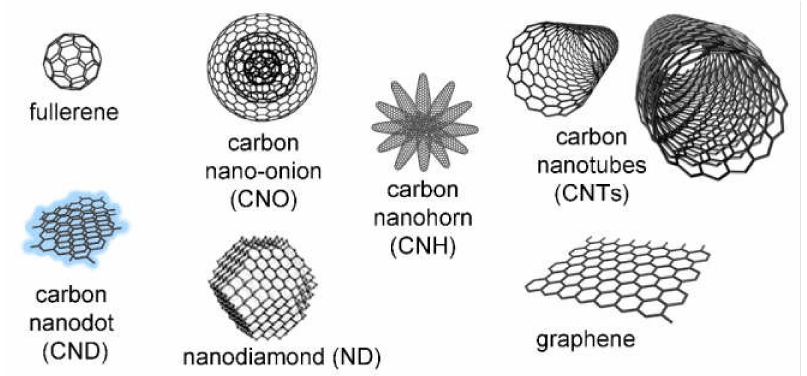
Figure 1. Carbon nanostructures (not to scale), reproduced from Adorinni, S. et. al. (2021) [41] under a Creative Commons license (https://creativecommons.org/licenses/by/4.0/). The nano-onion schematic structure is reproduced with permission from Ugarte, D. et al. (1996) [42], copyright ©1995